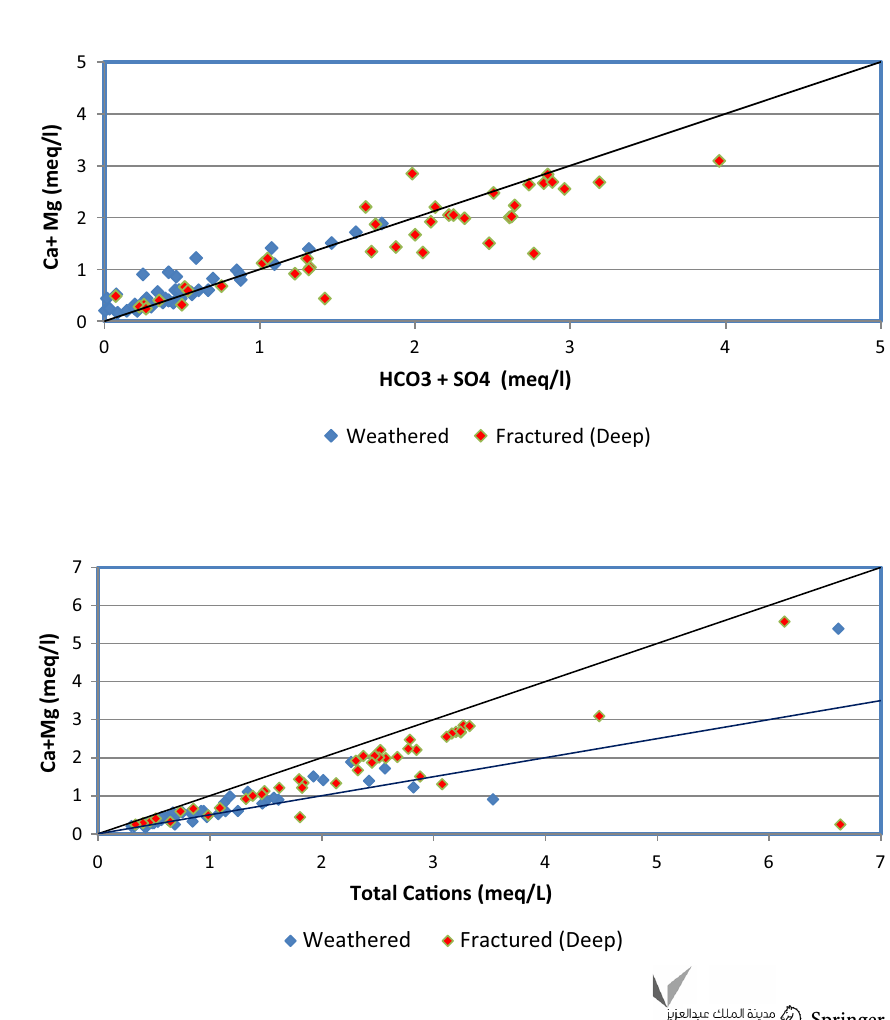
Fig. 6 Plots of Ca + Mg versus HCO 3 + SO 4